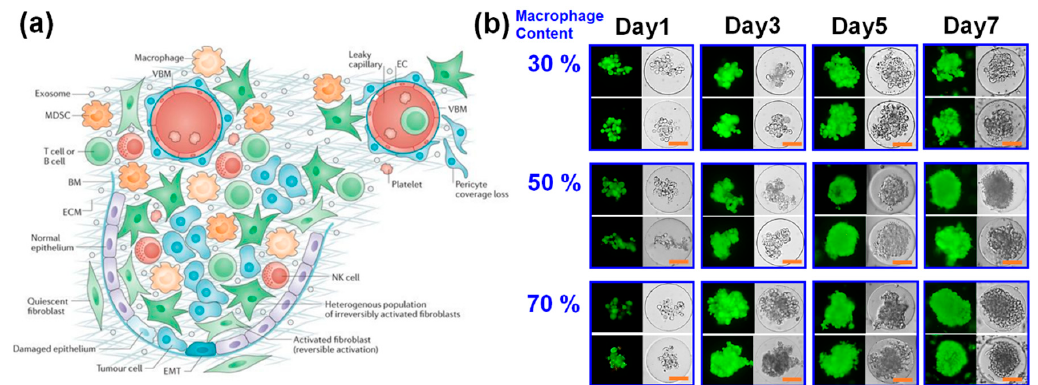
Figure 6. ( a ) Schematic illustration of tumor microenvironment, consisting of multiple types of cells. Reprinted with permission from ref. [46]. Copyright 2016 Springer Nature; ( b ) Optical (left) and fluorescent (right) microscopic images of microgels encapsulated with varying amounts of macrophages co-cultured with MCF-7 cells (scale bar: 50 um). The cells were fluorescently labeled to visualize live (green) and dead (red)